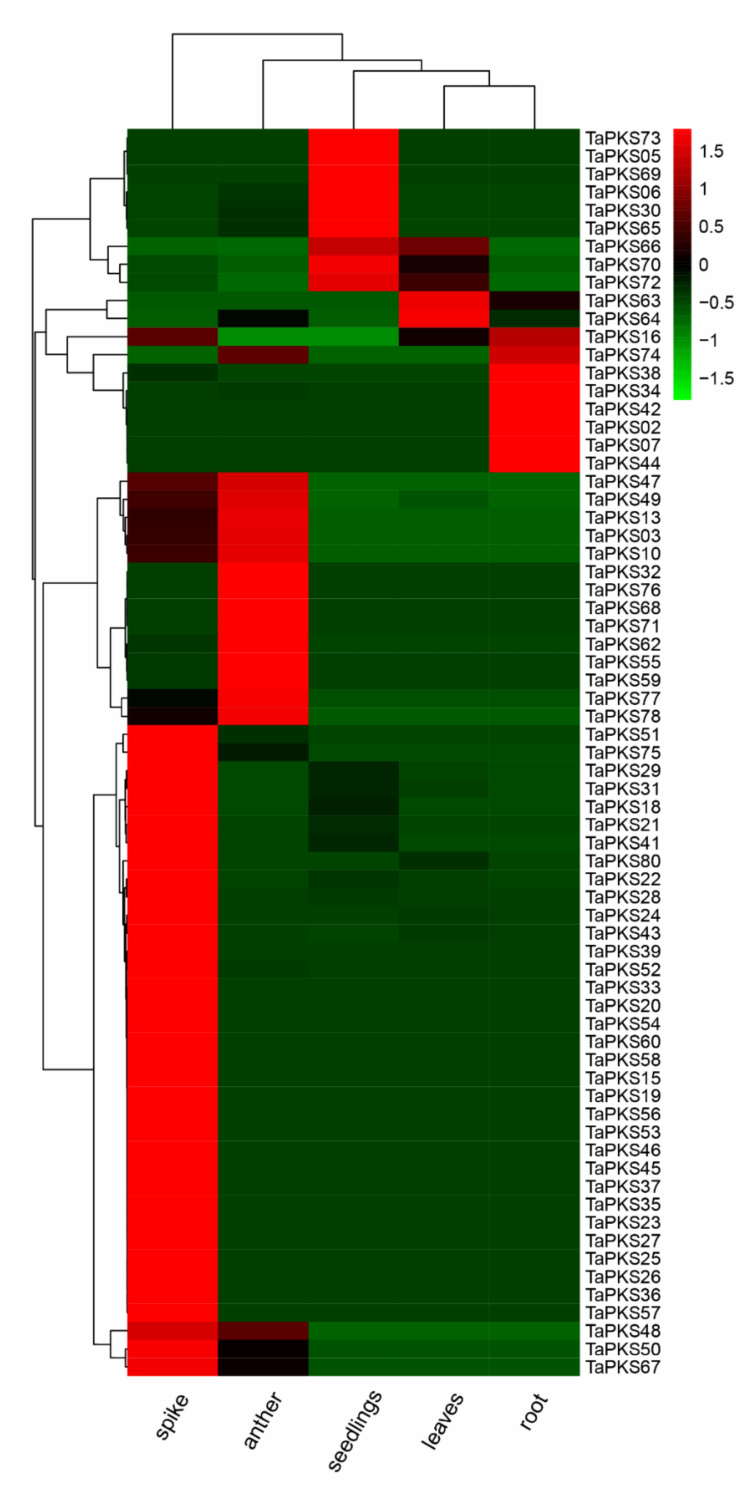
Figure 8. Cluster analysis of TaPKS gene expression in different tissues from Chinese Spring wheat. The tissue expression data used for mapping were obtained from Plant Public RNA-seq Database [22]. The change in the color of the box from green to red indicates that the gene expression level changes from low to